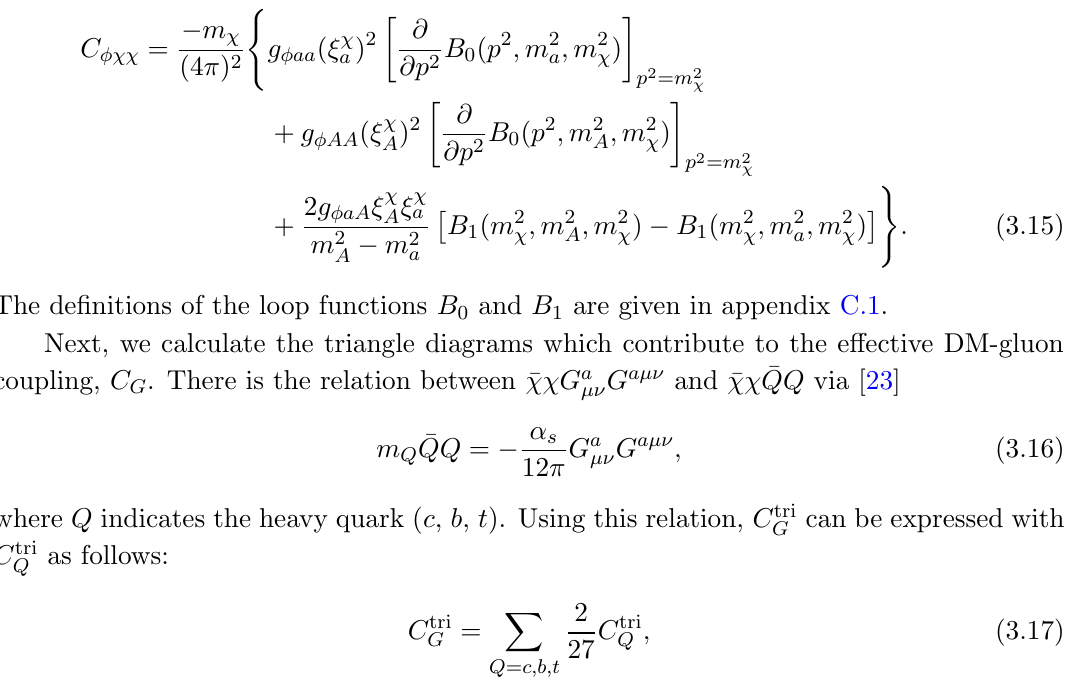
Figure 1 . Triangle diagrams which contribute to the DM-nucleon SI scattering. a pseudoscalar mediators, a and A . q in the external line stands for quarks. The diagrams with each of the light quarks ( u; d; s ) contribute to (cid:22) (cid:31)(cid:31) (cid:22) qq . The diagrams with heavy quarks ( c; b; t )